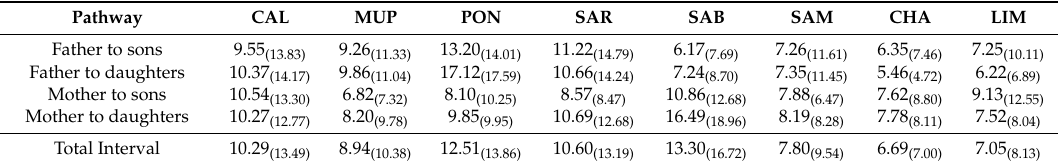
Table 3. Generation interval 1 in years for each breed 2 , calculated in the classical four pathways (standard deviations in parenthesis).